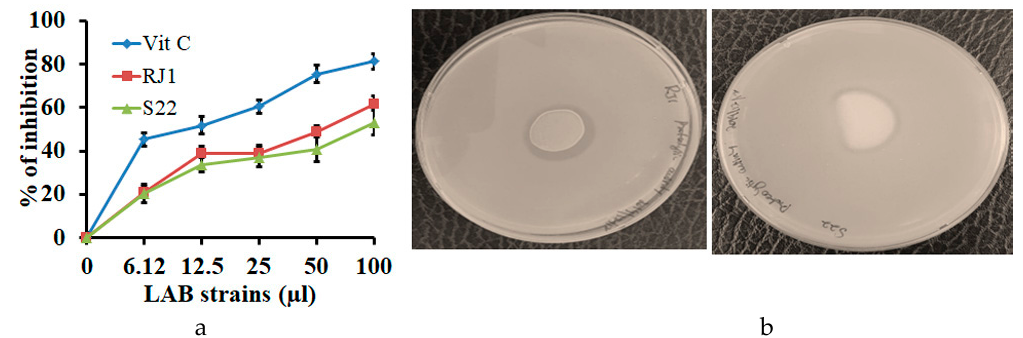
Figure 4. ( a ) DPPH free radical scavenging activity of RJ1 and S22 in vitro. The results are expressed as the mean values and standard error of three replicates ( n = 3). ( b ) The proteolytic screening assay shows a clear zone around the LAB spot. (Left plate) L. plantarum RJ1 and (right plate) P. pentosaceus S22 on a skim milk agar plate.